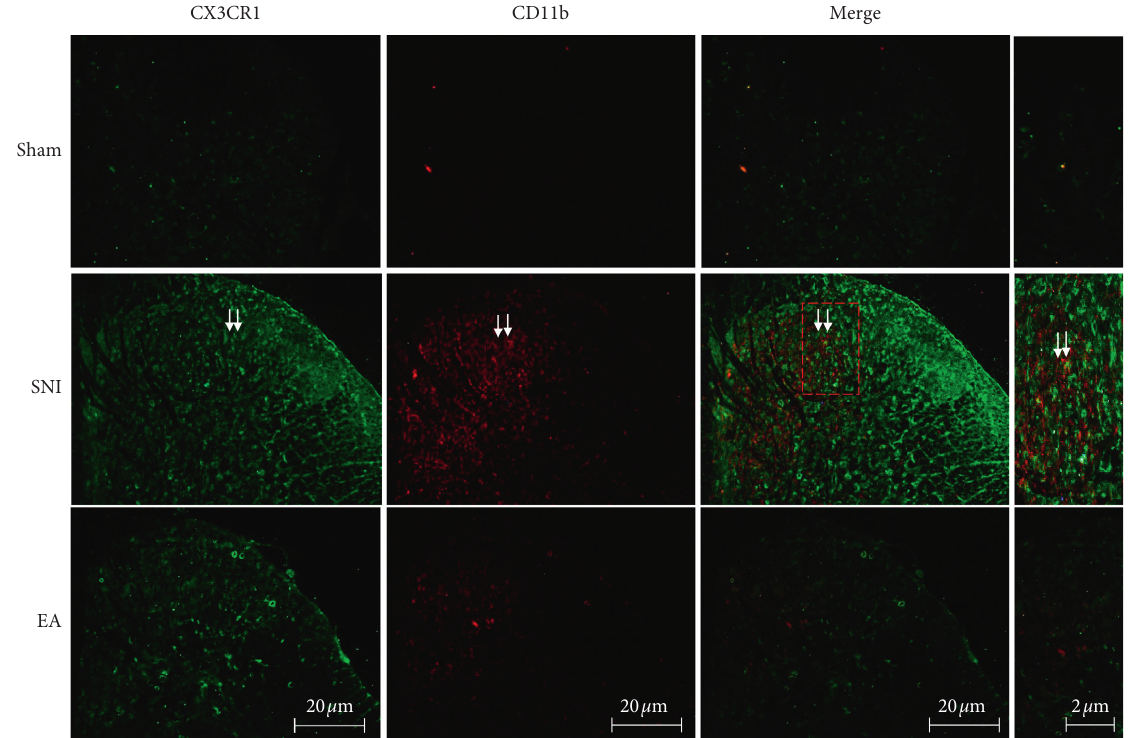
Figure 6: Immunofluorescence staining evaluated the effect of 2Hz EA on coexpression of spinal CX3CRl with CD11b following SNI. CX3CRl and CD11b were double-stained in the spinal dorsal horn from the sham, SNI, and SNI +EA group rats (scale bar � 20 μ m). Immunofluorescence staining data revealed that the SNI improved spinal CX3CRl and CD11b expression compared to the sham group. 2Hz EA treatment reversed the coexpression of CX3CRl (green) with microglial activation indicator CD11b (red) in the spinal cord of SNI